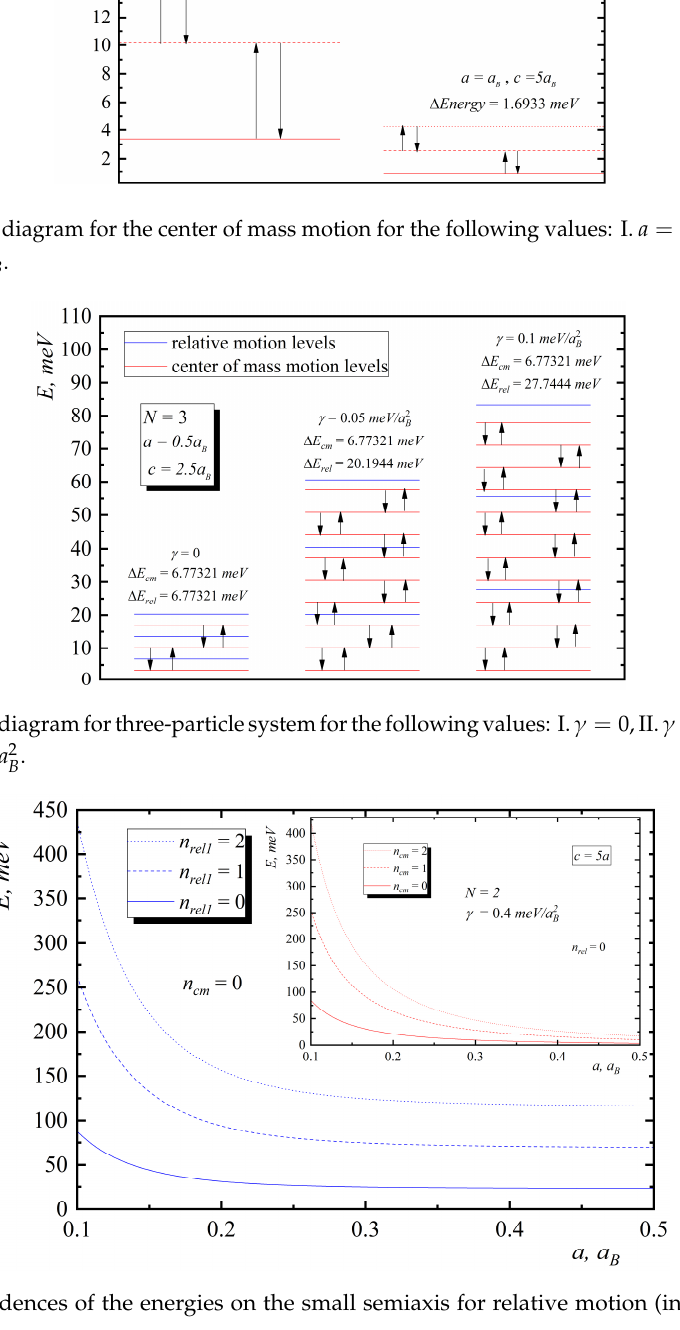
Figure 7. Dependences of the energies on the small semiaxis for relative motion (insert – center of mass motion).